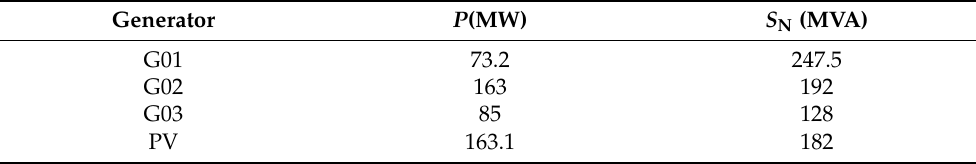
The capacity of each generator ( S N ), The active power output of each generator ( P ). Table 2. Parameters of the established PV generator. Table 2. Parameters of the established PV generator.